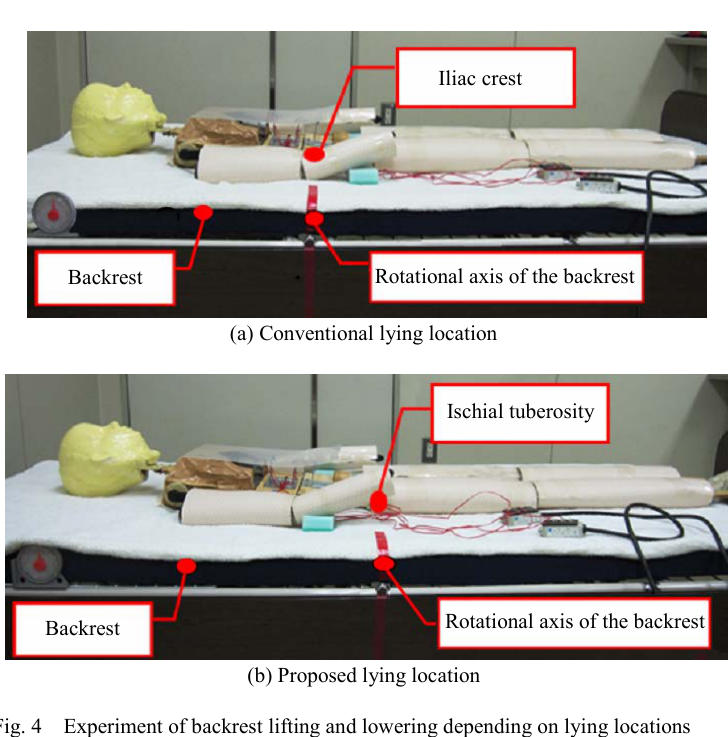
Fig. 4 Experiment of backrest lifting and lowering depending on lying